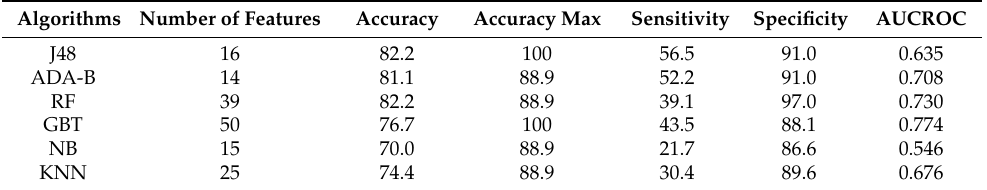
Table 3. Evaluation metrics (%) of the models computed using hold-out, backward feature elimina- tion, 10-fold cross